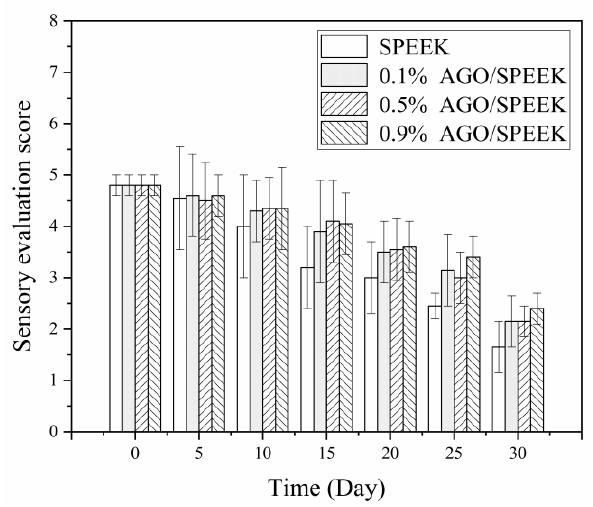
Figure 6. Sensory evaluation scores of AGO/SPEEK films in the storage of cherry tomatoes (a 5-point scale: 1 means unacceptable, 2 means barely accepted, 3 means general, 4 means good, and 5 means excellent).